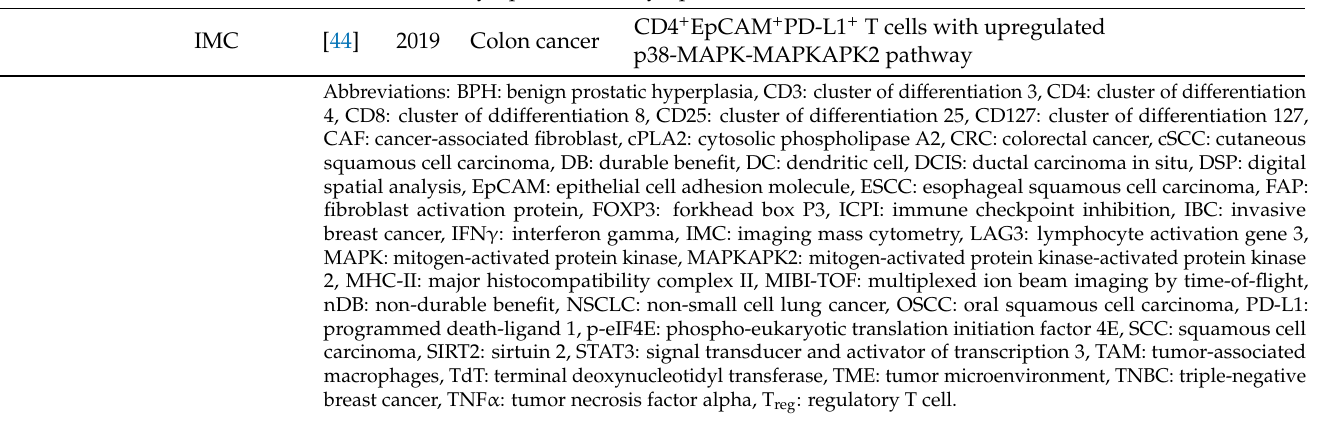
Table 3. Summary table of multiplex imaging studies that describe clinical outcomes, treatment responses, biomarkers, and tumor classification and grading. Described